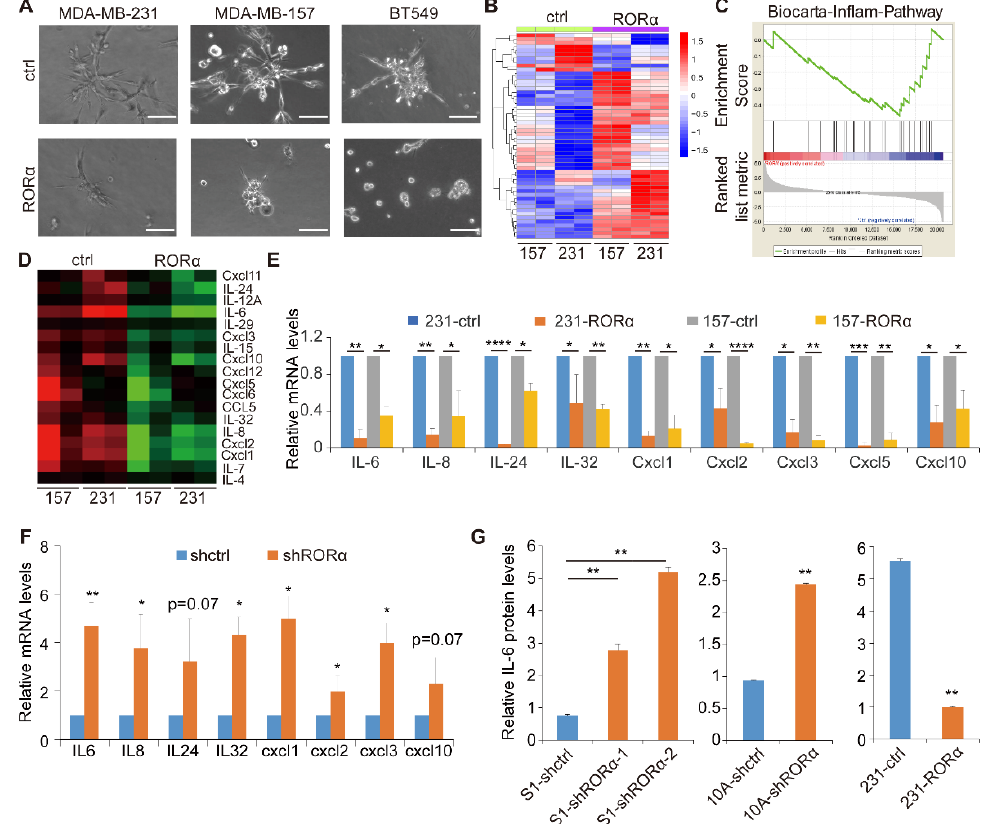
Figure 1. ROR α expression suppresses cytokine gene expression in mammary epithelial cells. ( A ) Phase images showing control and ROR α -expressing MDA-MB-231, MDA-MB-157, and BT-549 cells in 3D culture after being plated for 4 days. Bar: 100 µm. ( B ) Heatmap showing different gene expression profiles in control and ROR α -expressing MDA-MB-231 and MDA-MB-157 cells. ( C ) Gene set enrichment analysis (GSEA) data showed that the inflammatory pathway was inhibited by ROR α in MDA-MB-231 and MDA-MB-157 cells in 3D culture. ( D ) Heatmap showing cytokine gene expression in control and ROR α -expressing MDA-MB-231 cells in 3D culture. ( E ) Real-time RT-PCR quantified mRNA levels of cytokines genes in control and ROR α -expressing MDA-MB-231 and MDA-MB-157 cells; results are presented as mean ± SEM; n =4, **** p < 0.0001, *** p < 0.001, ** p < 0.01, * p < 0.05, one-way ANOVA test. ( F ) Real-time RT-PCR quantified cytokines gene expression in control and ROR α -silenced S1 cells; results are presented as mean ± SEM; n =4, ** p <0.01, * p <0.05, student’s t-tests. ( G ) ELISA analysis quantified the protein levels of IL-6 in the conditioned medium collected from control and ROR α -silenced S1 and MCF-10A cells, and from control and ROR α -expressing MDA-MB-231 cells; results are presented as mean ± SEM; n = 3, ** p < 0.01, * p < 0.05, one-way ANOVA